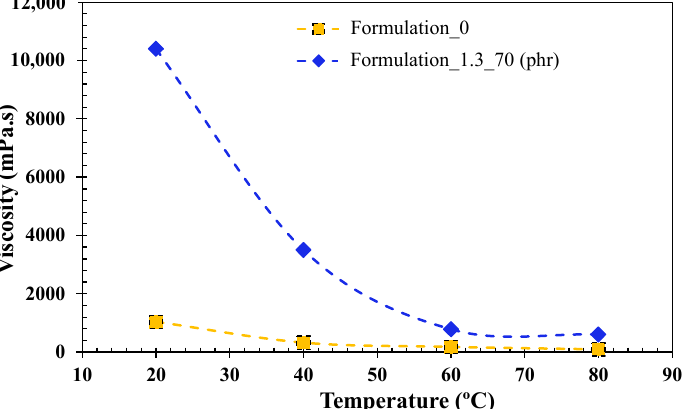
Figure 4. Viscosity profile of UV resin and formulation 1.3 with 70 (phr) as a function of temperature. Depicted dashes are for visual interpretation.